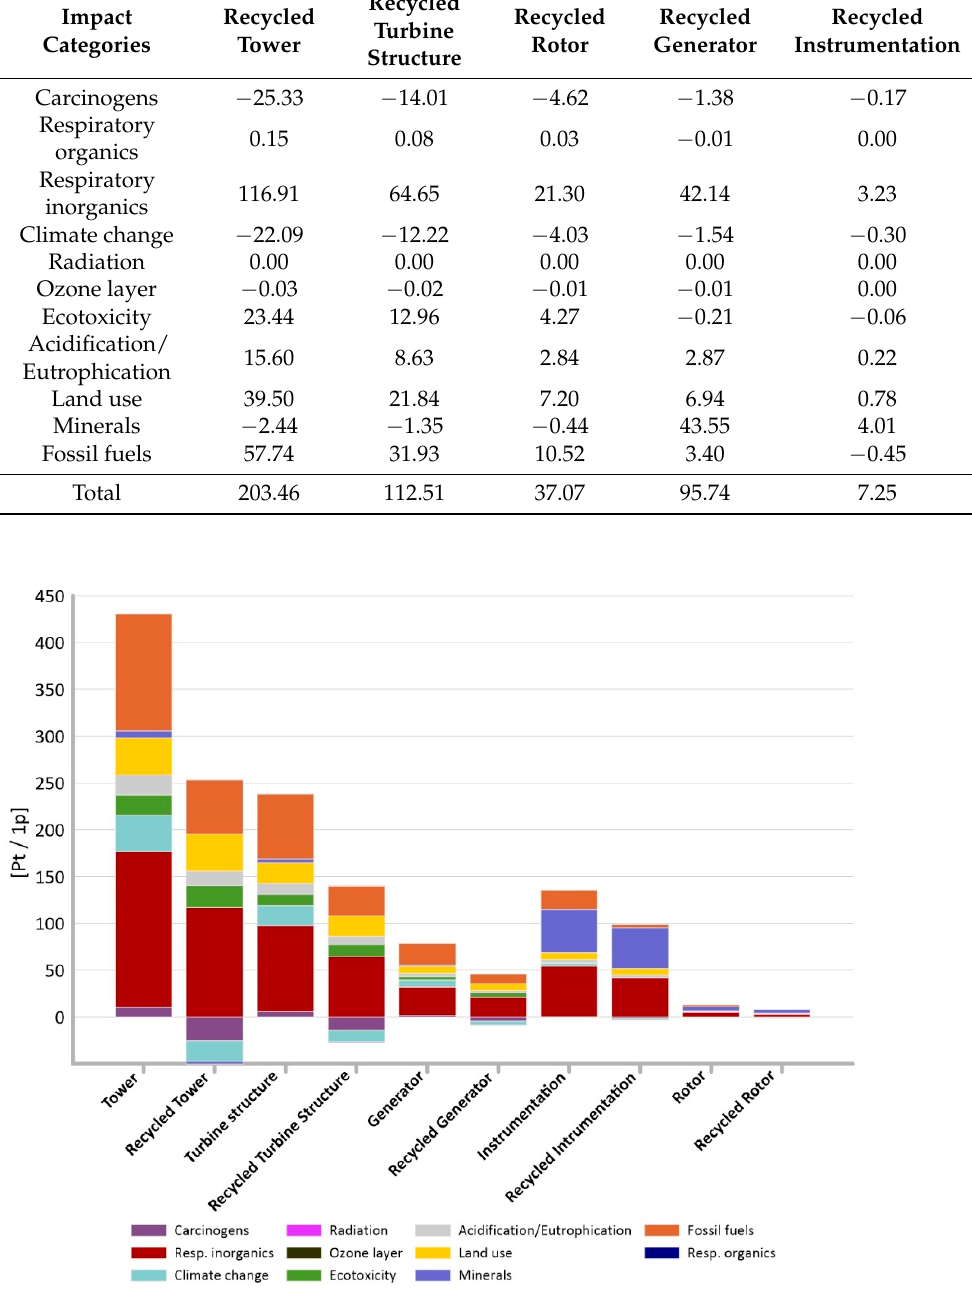
Figure 4. Results of grouping and weighting of individual elements of an innovative power plant for methods with and without recycling.